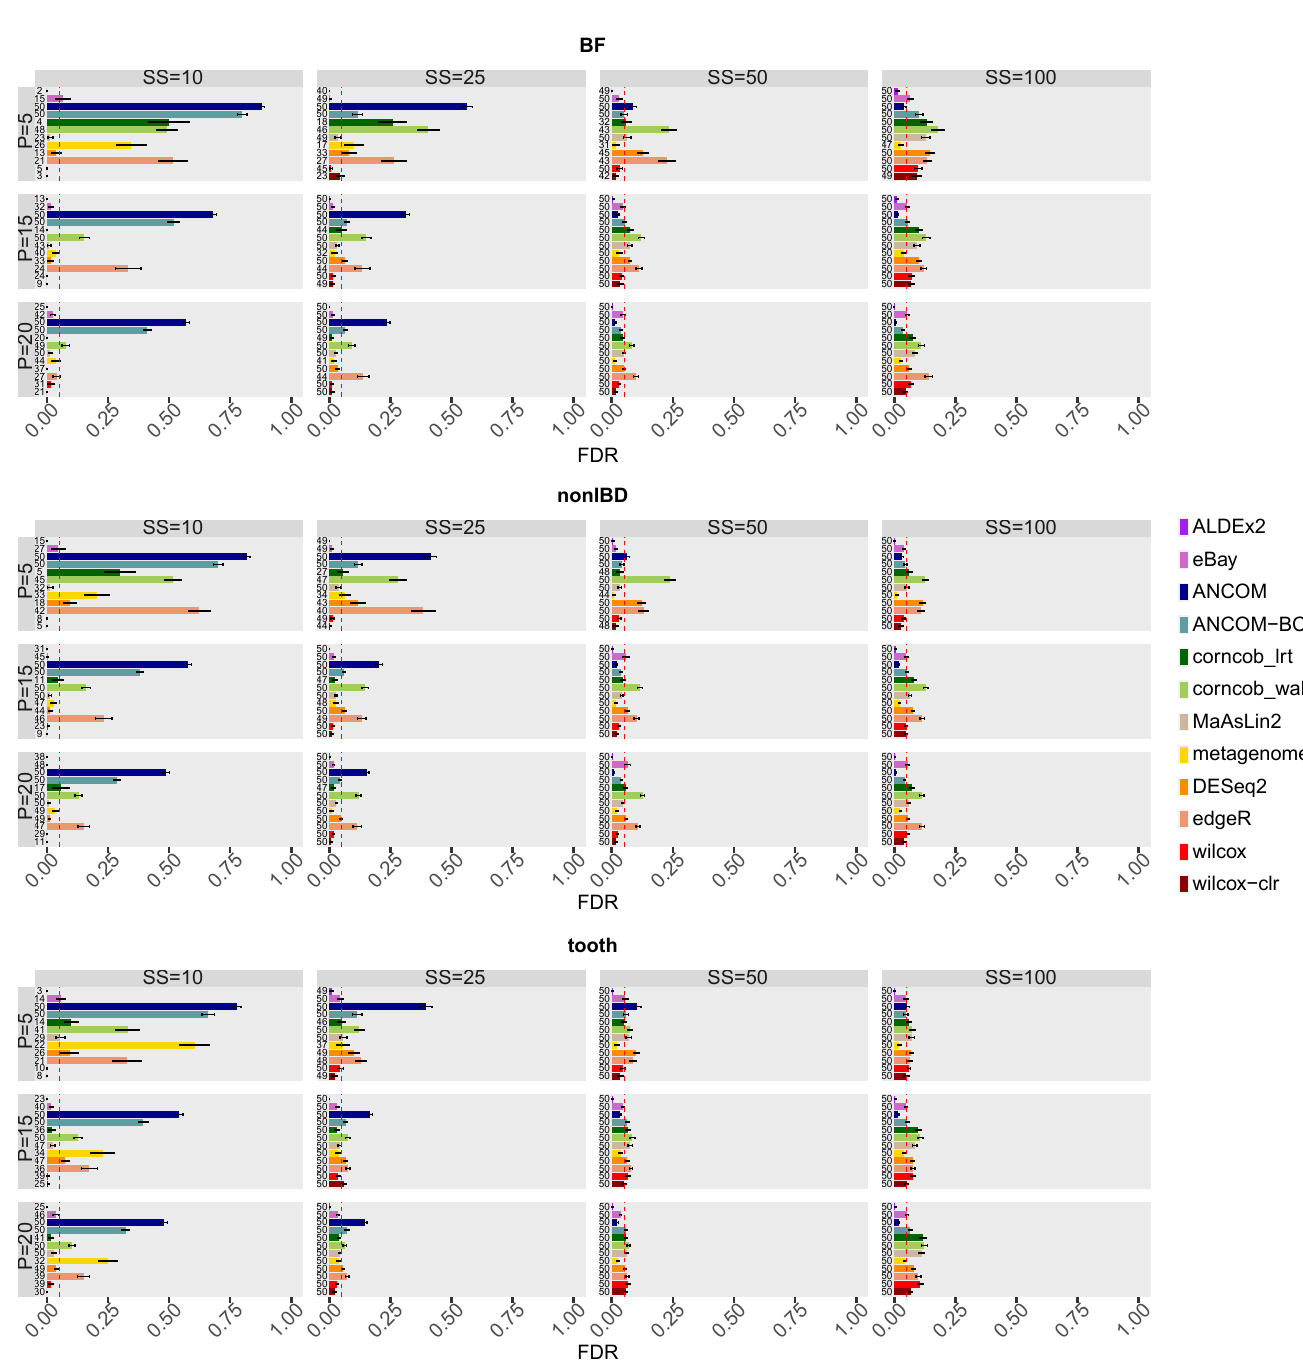
Fig 4. False Discovery Rate (FDR) of each differential abundance method for each dataset considered in the comparison in the main scenario with simulated DA features. In each set of boxes corresponding to the dataset, different percentages (P) of simulated DA features are on rows, while different sample size (SS) values are on columns. The FDR values are averaged over the 50 simulations and the bars show the standard error. The number of runs that provide a defined value of FDR is shown at the beginning of the bars.